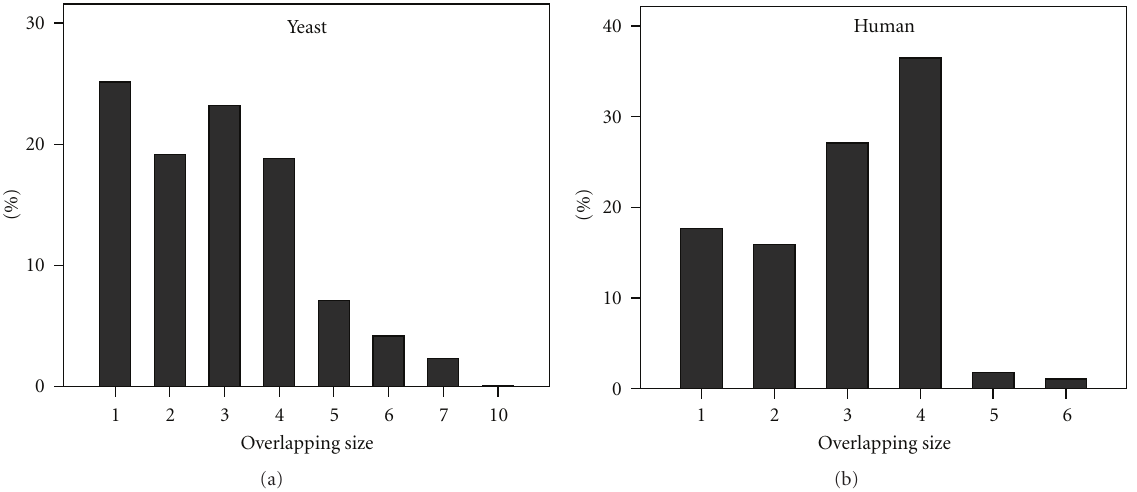
Figure 5: Overlapping size distribution of yeast and human PPI network. The x -axis represents the overlapping size. The y -axis is the percentage of each size. (a) Yeast PPI network. (b) Human PPI network.